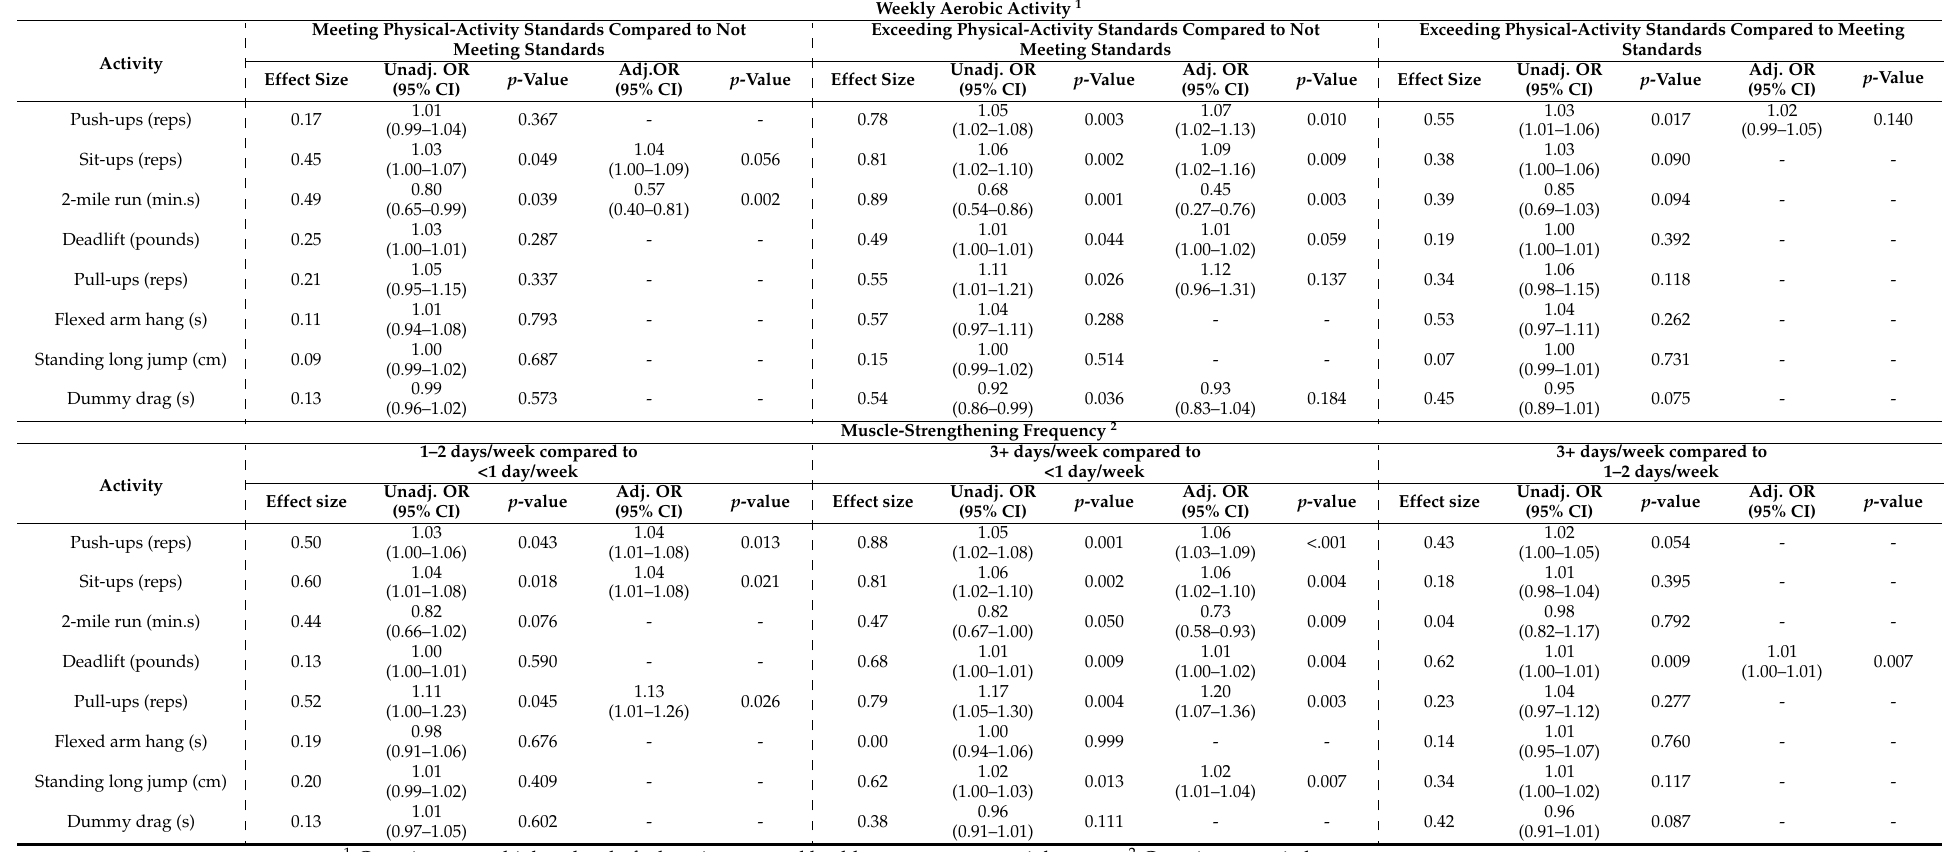
Table 4. Bivariate logistic regression results comparing differences between levels of physical activity and fitness test